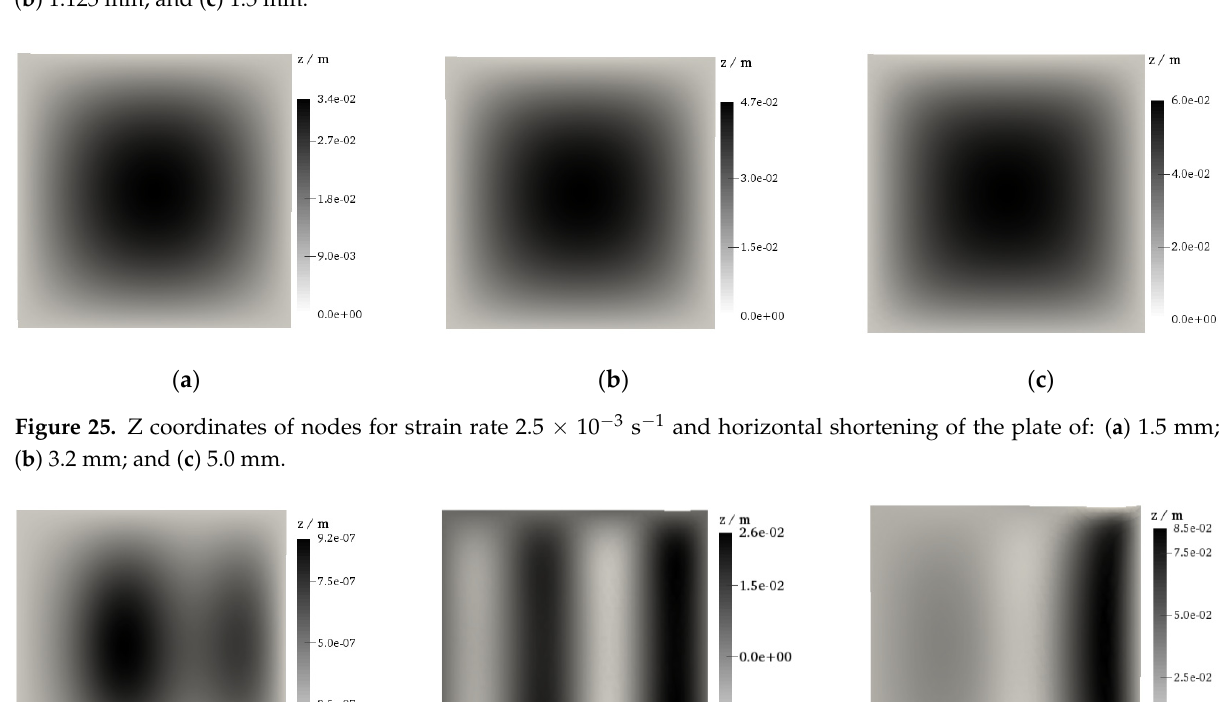
Figure 24. Z coordinates of nodes for strain rate 2.5 × 10 − 5 s − 1 and horizontal shortening of the plate of: ( a ) 0.75 mm; ( b ) 1.125 mm; and ( c ) 1.5 mm.